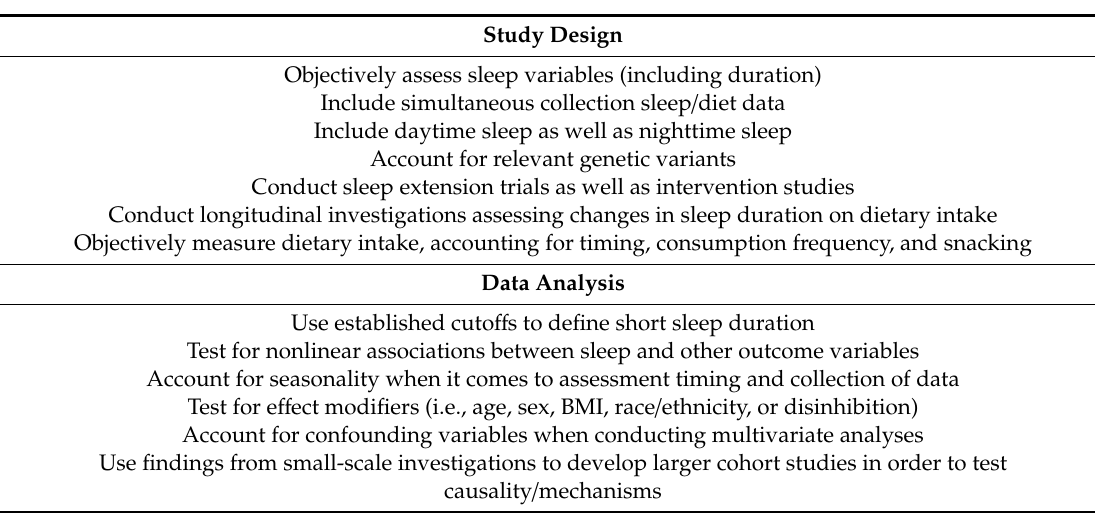
Table 2. The relationship between sleep duration and dietary intake: study design recommendations for future investigations